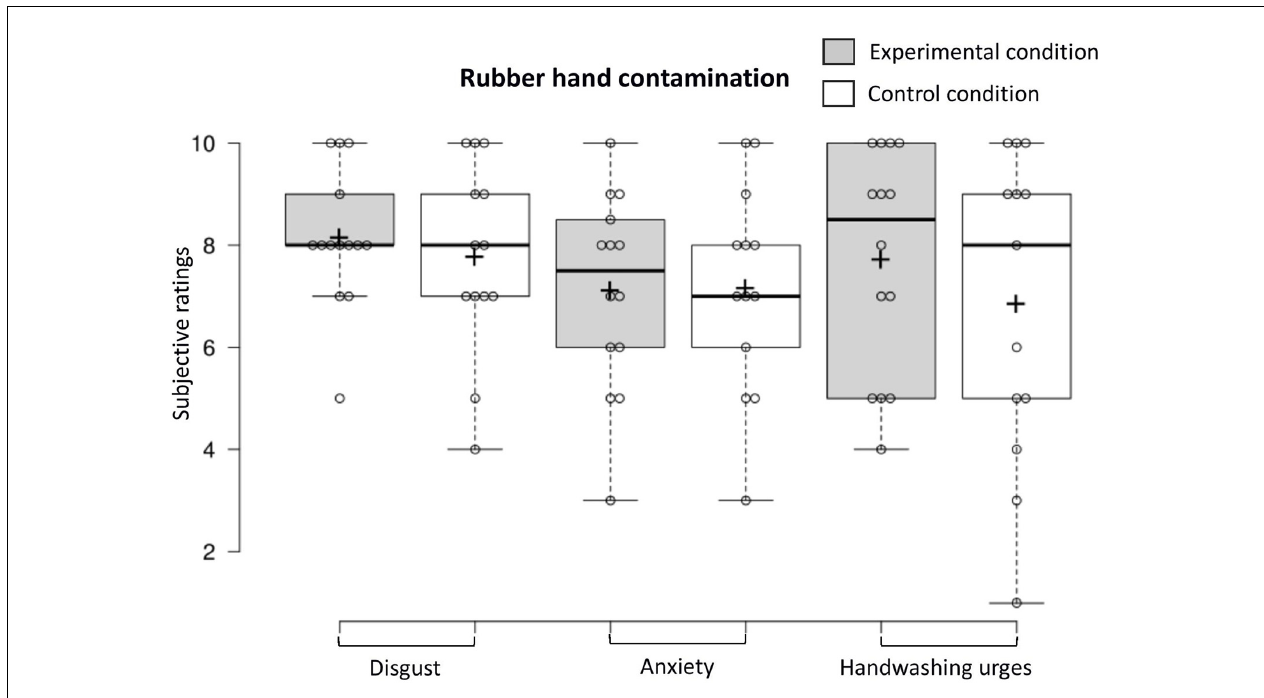
FIGURE 6 | Contamination sensations ratings in the experimental and control condition during the rubber hand contamination procedure.